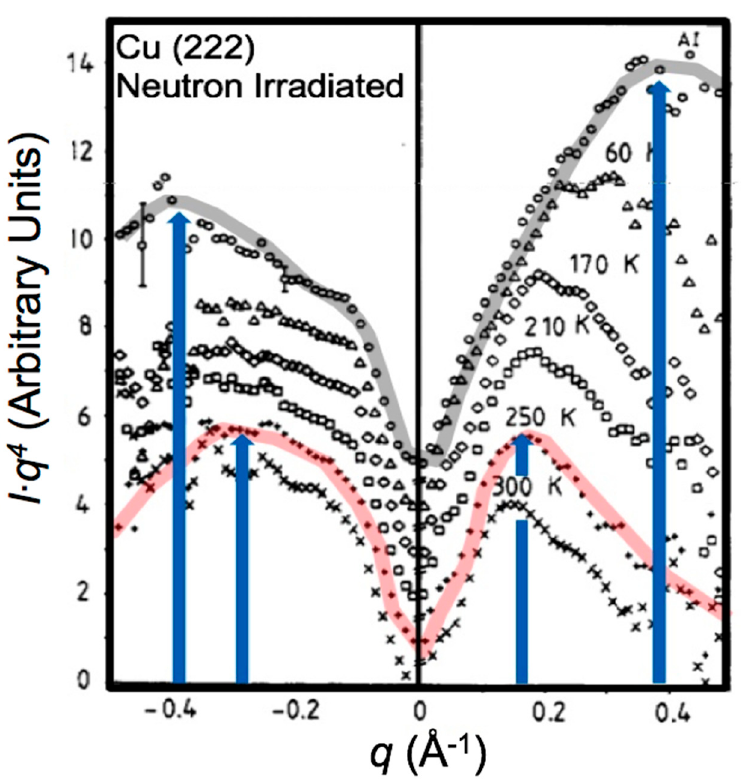
Figure 7. Diffuse scattering measurements at the (222) reflection from defect clusters in Cu after low-temperature neutron irradiation (AI) and after annealing to the indicated temperatures. The measurements are scaled by q 4 and the data for each temperature are offset for clarity to avoid overlap. Adapted from Figure 4 in Reference [35] with permission.